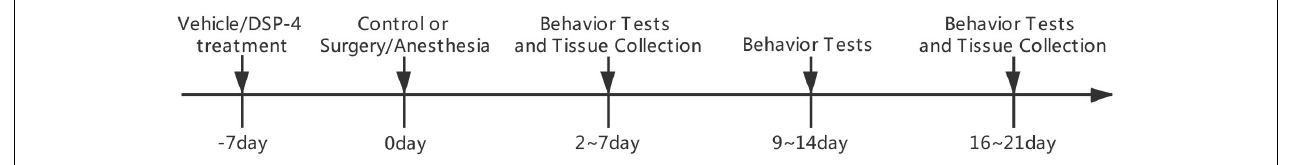
FIGURE 1 | Diagram of the experimental design. Groups V+S and D+S were operated on 7 days after intracerebroventricular injection. Behavioral tests 1, 2, and 3 weeks after the surgery, including a series of tests, started on days 2, 9, or 16 and lasted for 5 days. Rats were sacrificed 1 day after the last behavioral tests in the 1st and 3rd week after the